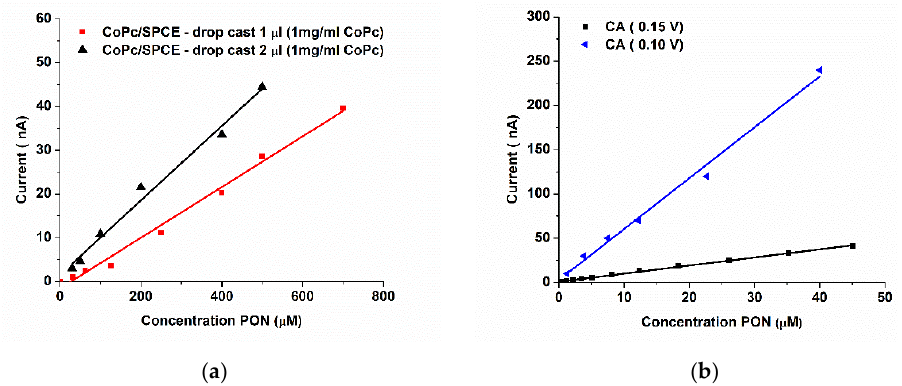
Figure 5. ( a ) Calibration curves for 1 µL and 2 µL drop-casted CoPc solution (1 mg/mL in DMF) on the SPCE (from DPV measurements) ( b ) Calibration curves from the amperometric response at +0.15 V (black) and +0.10 V (blue), using a GCE/CoPc electrode.